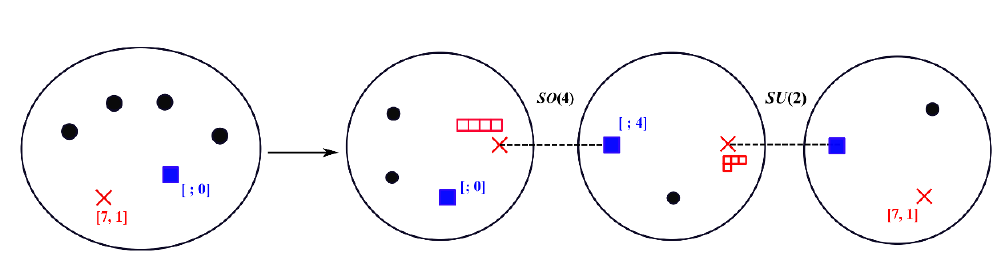
Figure 10 . S-duality for D 4 theory of class (3 ; 2). Here we pick the coe(cid:14)cient matrices to be of type [1 ; 1 ; 1 ; 1; 0], with a trivial regular puncture (this setup can be relaxed to general D 4 regular punctures). In the degeneration limit, we get SO(4) (cid:2) SU(2) gauge group plus three Argyes-Douglas matter. The leftmost theory is in fact two copies of ( A 1 ; D 5 ) theory, while the middle theory is given